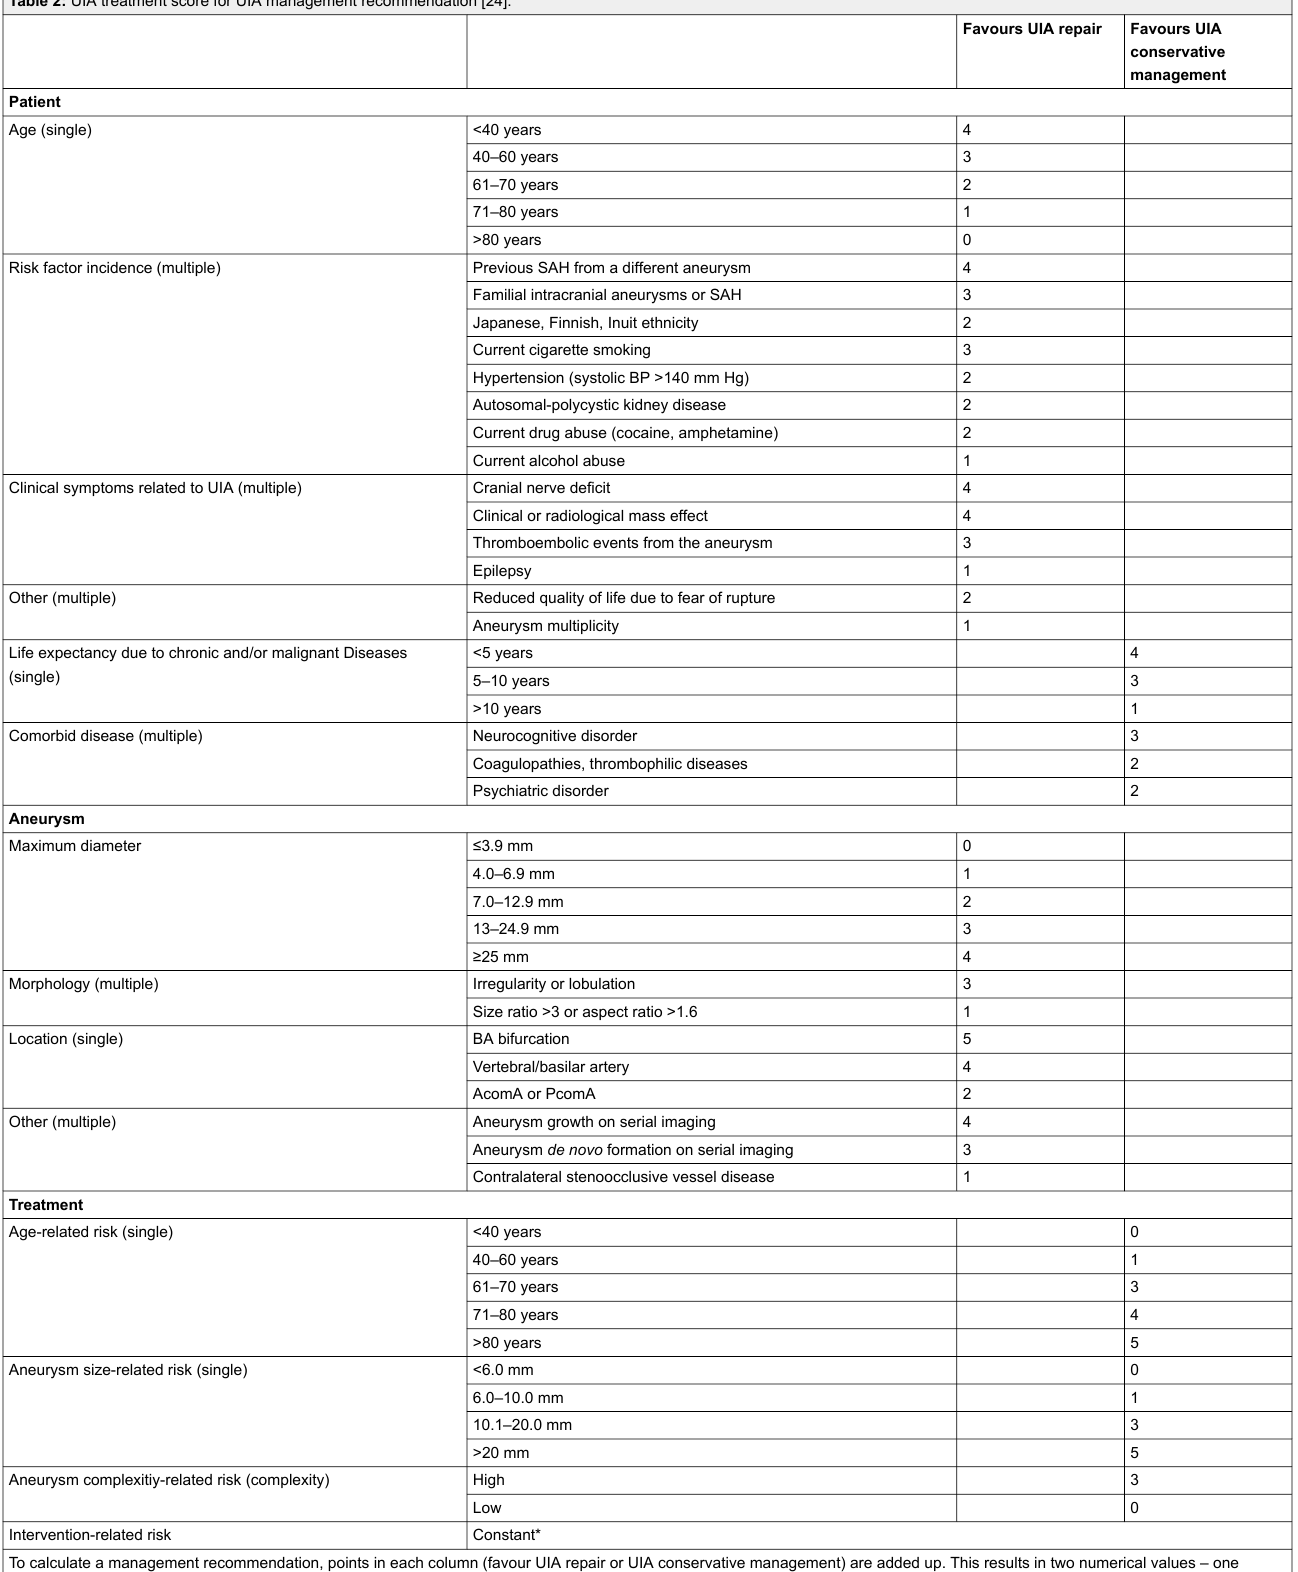
Table 2: UIA treatment score for UIA management recommendation